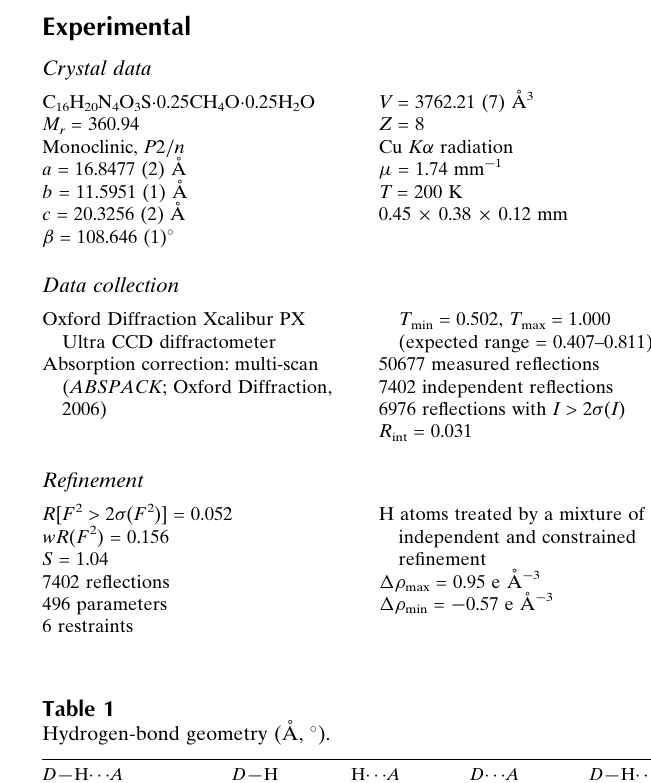
Hydrogen-bond geometry (A˚ , (cid:2) ). D —H (cid:1)(cid:1)(cid:1)